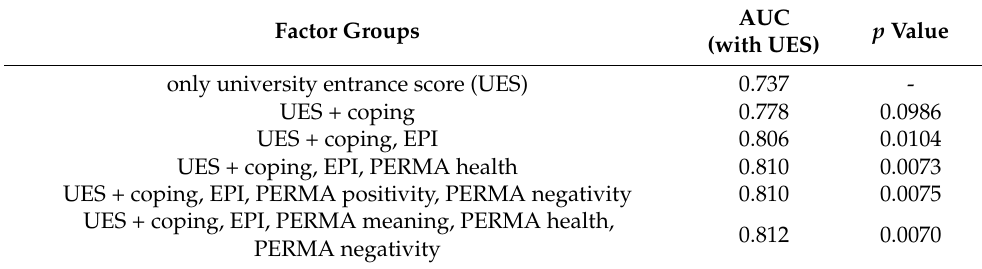
Table 5. The best performing singleton, pair, triplet, quadruplet, and quintuplets together with their AUC and the corresponding p values. (University entrance score is always incorporated in the models). AUC p Value Factor Groups (with UES) only university entrance score (UES) 0.737 - UES + coping 0.778 0.0986 UES + coping, EPI 0.806 0.0104 UES + coping, EPI, PERMA health 0.810 0.0073 UES + coping, EPI, PERMA positivity, PERMA negativity 0.810 0.0075 UES + coping, EPI, PERMA meaning, PERMA health, 0.812 PERMA negativity